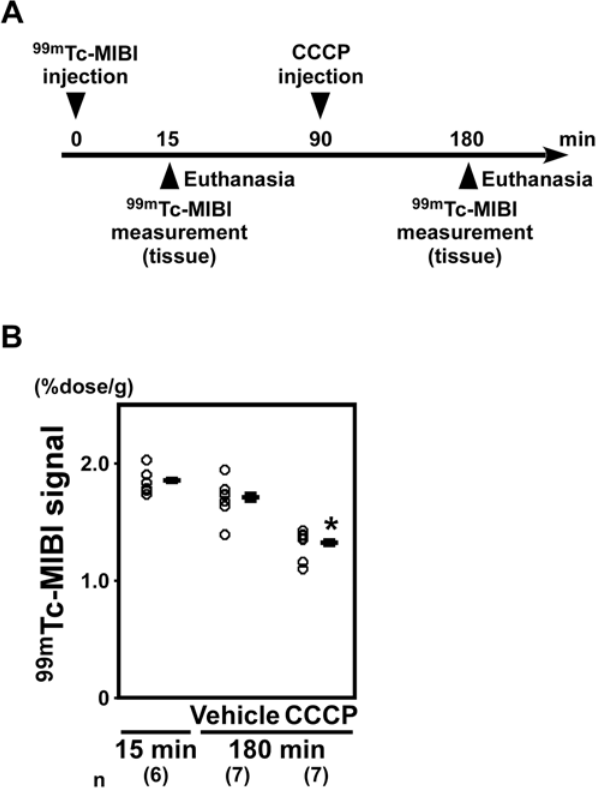
Figure 3. 99m Tc-MIBI signals were decreased in the hearts of rats administered CCCP. (A) A schematic of the experiment to investigate whether CCCP decreased the 99m Tc-MIBI signals in rats. (B) At 180 min after 99m Tc-MIBI injection, the 99m Tc-MIBI signals of the hearts in the CCCP group were significantly lower than those in the rats administered vehicle (n = 7 in each group). * P < 0.05 versus vehicle.